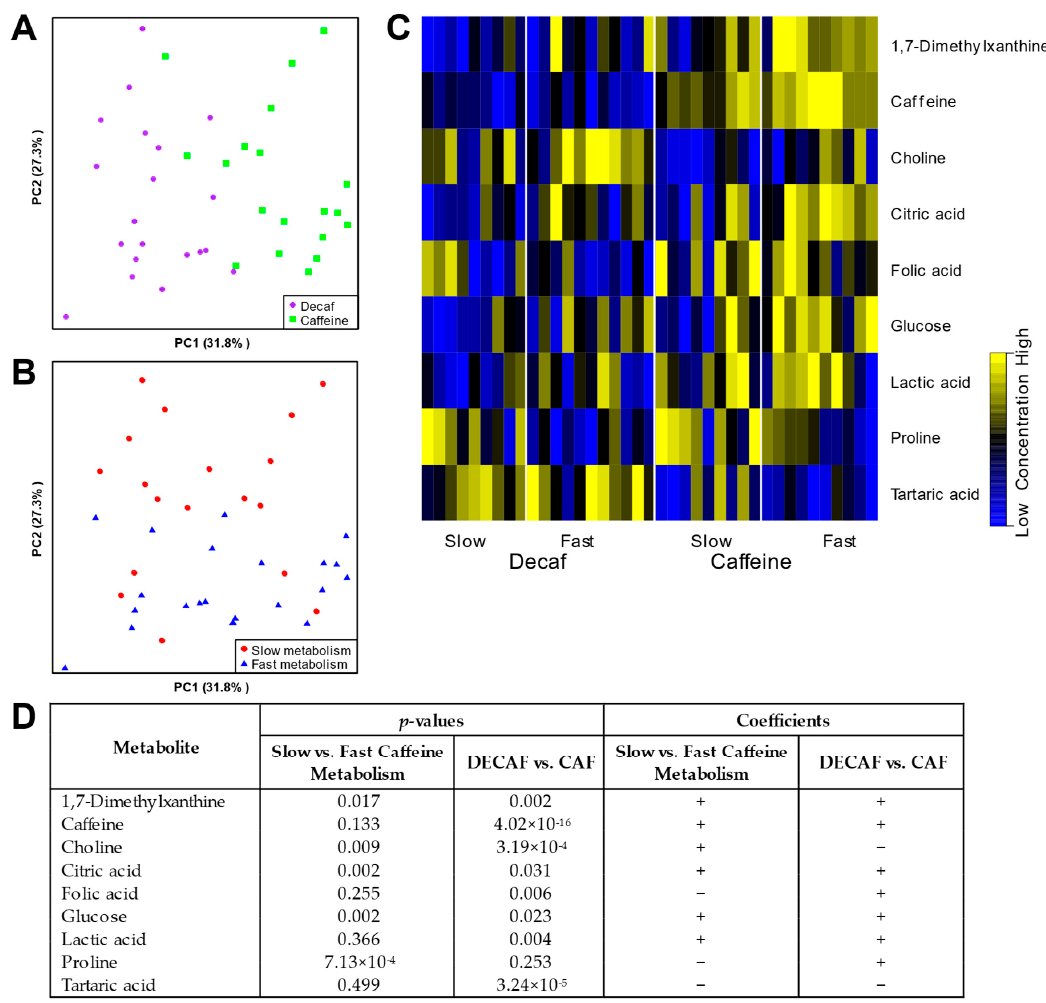
Figure 3. Serum metabolomics ( 1 H-NMR) of 120 min time point of each OGTT. ( A ) Principal component analysis (PCA) showing separation of DECAF and CAF treatments. ( B ) PCA analysis showing separation of slow and fast allele scores. ( C ) Heatmap depicting significant changes between both DECAF and CAF treatments as well as slow and fast allele scores. ( D ) Table of serum metabolites significantly correlating with caffeine intake and/or caffeine metabolism score along with their p -values and direction (either + or − ) of coefficient change.